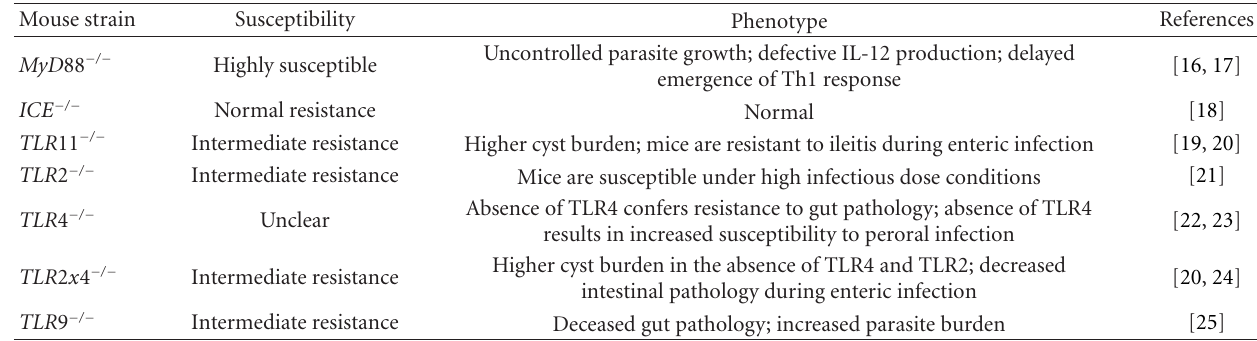
Table 1: Summary of findings in TLR/MyD88 knockout